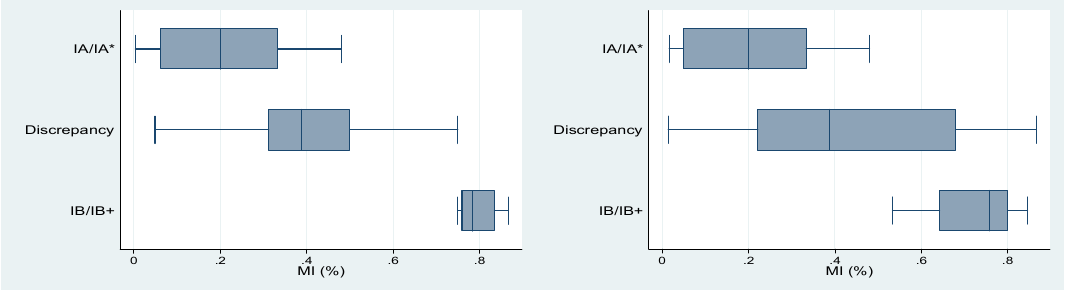
Figure 5. Box and Whisker Plot of data from AI interpretation and pathological stages (contrast- Figure5. BoxandWhiskerPlotofdatafromAIinterpretationandpathologicalstages(contrast-enhanced enhanced T1w and T2w). T1w and